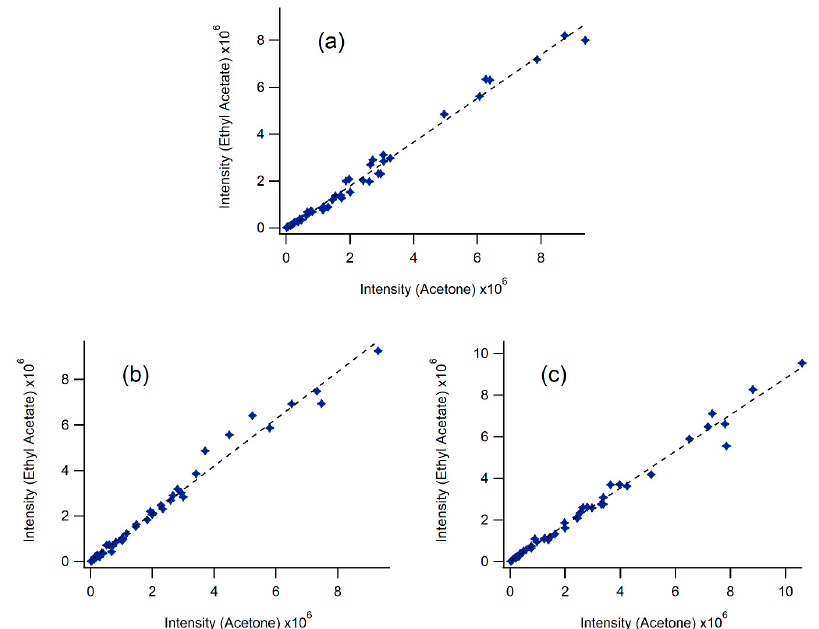
Figure 11. A comparison of LC-MS signals from samples prepared using ethyl acetate and acetone with ( a ) microwave-assisted, ( b ) Soxhlet and ( c ) ultrasound-assisted extraction techniques.